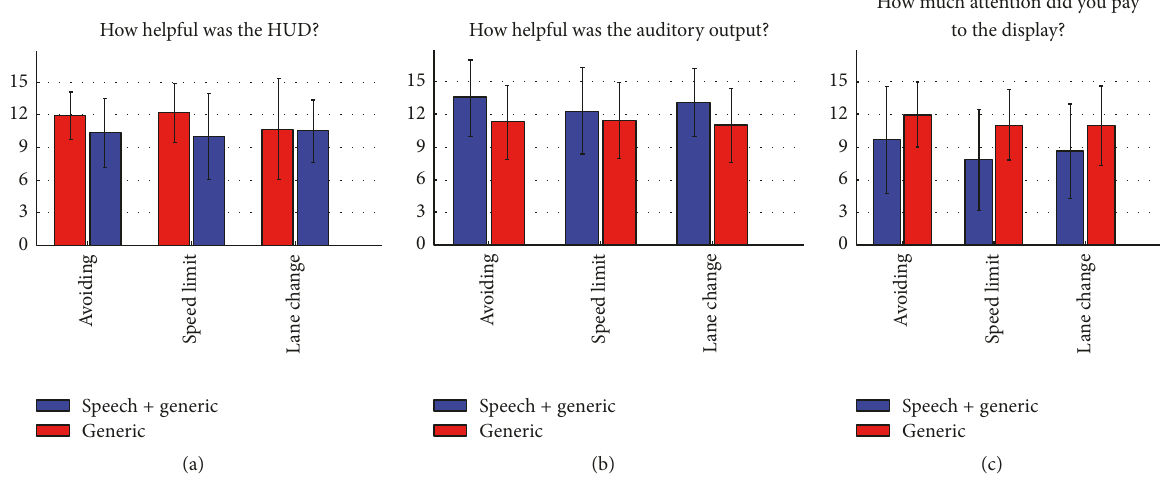
Figure 5: Usefulness ratings of the visual and auditory components of the HMI and visual workload (a–c).